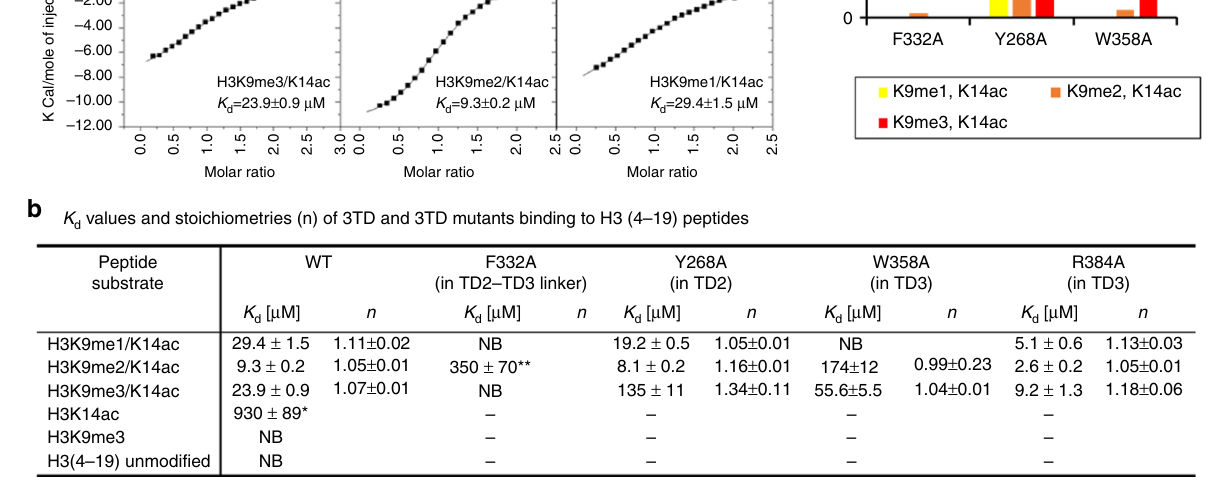
Fig. 2 3TD binding to different H3 peptides analyzed by ITC. a Representative ITC curves and dissociation constants of 3TD binding to different H3 peptides. b Compilation of dissociation constants of 3TD and 3TD mutants to different peptides (Supplementary Figs. 1b,c, and 6). c Relative binding af fi nity of F332A, Y268A, and W358A to K9me1/2/3-K14ac peptides. While F332A has generally reduced binding, Y268A shows a speci fi c loss in binding of K9me3 – K14ac and W385A shows a preferential reduction of K9me1/2 – K14ac